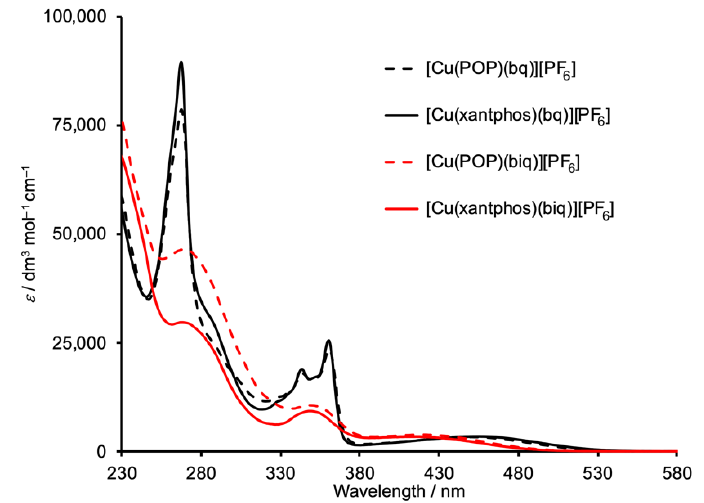
Figure 7. Solution absorption spectra of [Cu(POP)(biq)][PF 6 ] and [Cu(xantphos)(biq)][PF 6 ] compared to their 2,2'-biquinoline (bq) analogs (CH 2 Cl 2 , 2.5 × 10 –5 mol dm –3 ). Table 2. Absorption maxima for CH 2 Cl 2 solutions of [Cu(POP)(biq)][PF 6 ] and [Cu(xantphos)(biq)][PF 6 ] (2.5 × 10 −5 mol dm −3 ).